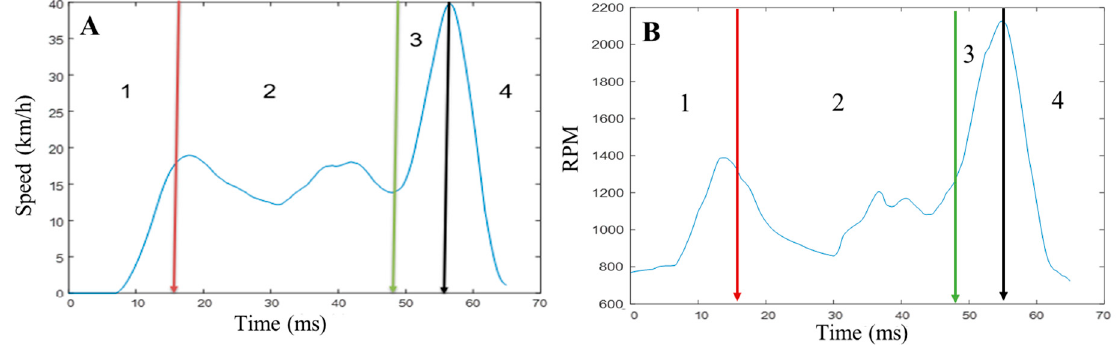
Figure 16. ( A ) Average speed and ( B ) engine rpm for speed monitoring.